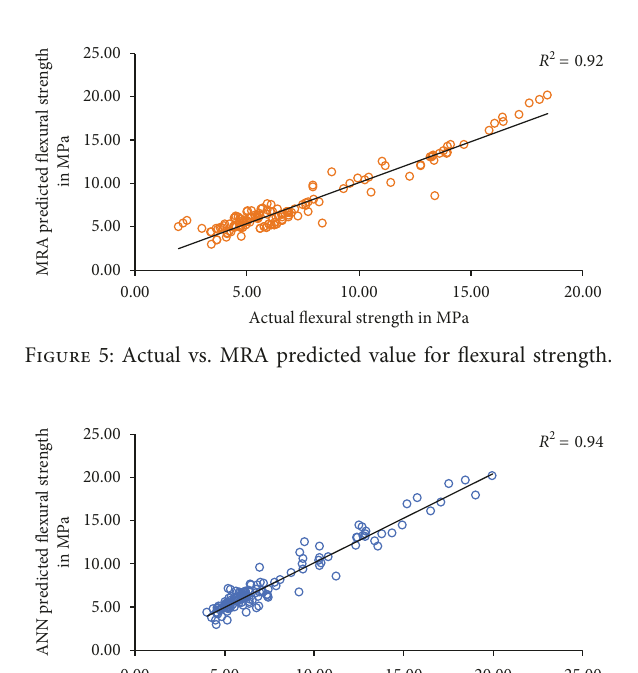
Figure 6: Actual vs. ANN predicted value for flexural